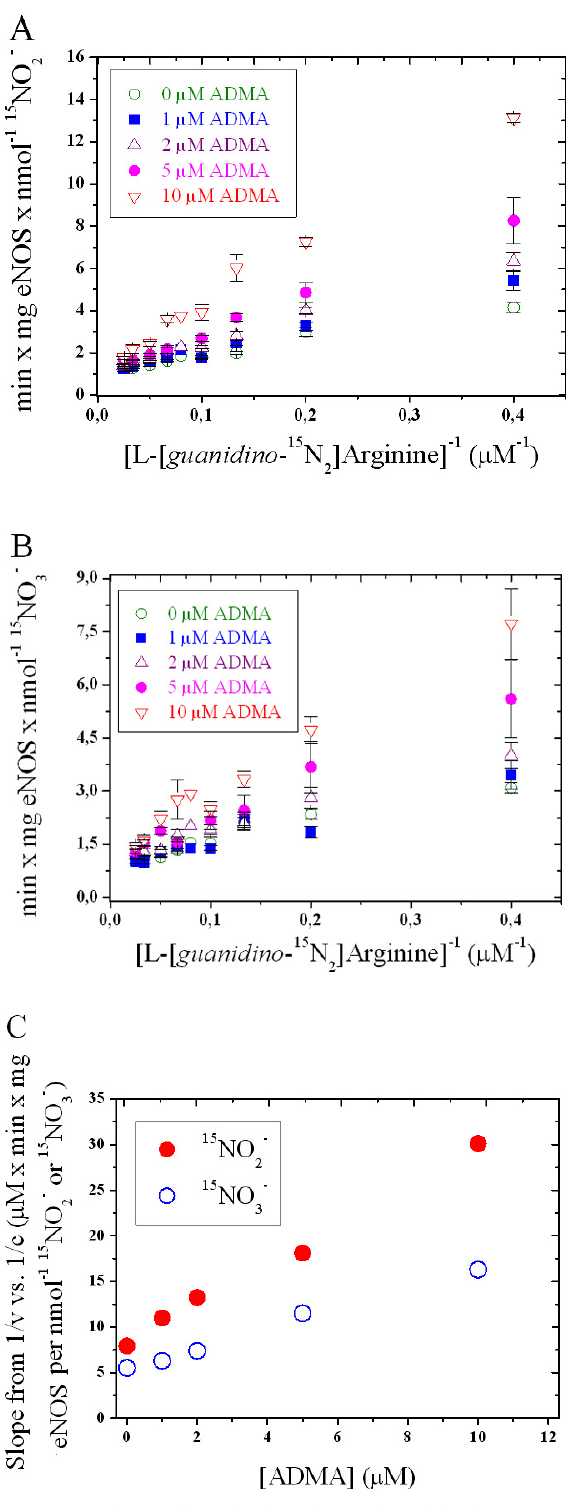
Figure 2. Primary (A and B) and secondary (C) Lineweaver- Burk plots for 15 NO 2 – and 15 NO 3 – . The experimental conditions are described in the “ Materials and Methods ”